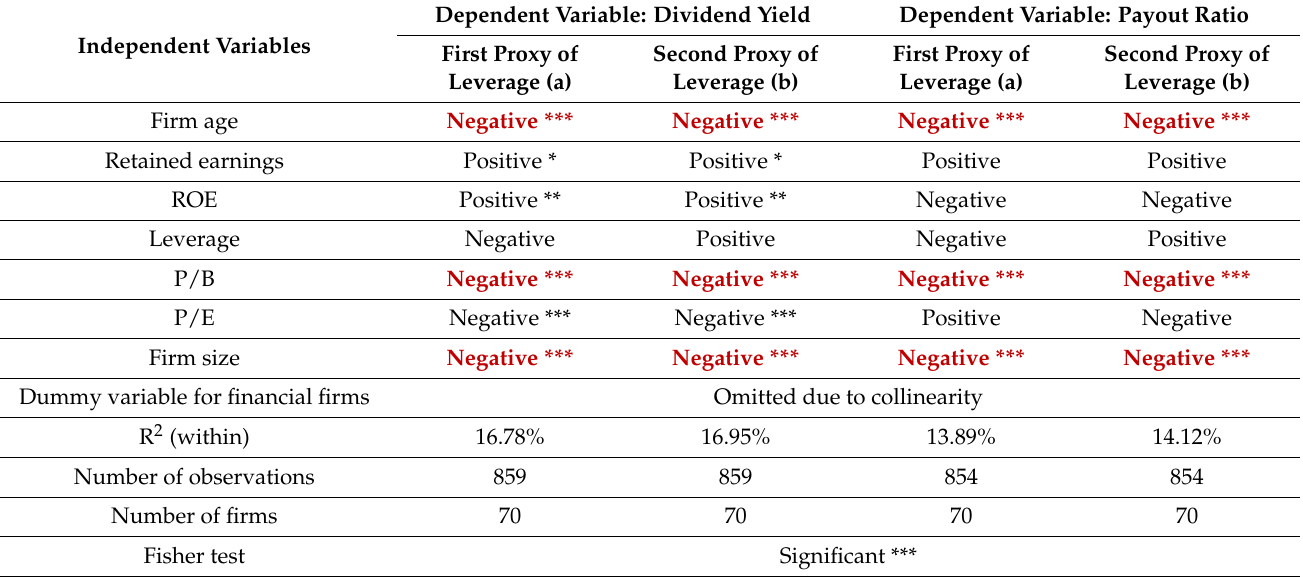
Table 5. Synthesis of the empirical results. These regressions used the fixed effect model. Significant results are followed by one asterisk * if the statistical test is significant with α = 10%; two asterisks